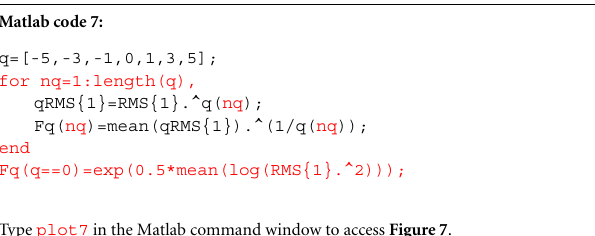
FIGURE 6 |The range of Hurst exponents defines a continuum of fractal structures between white noise ( H = 0.5) and Brown noise ( H = 1.5). The pink noise H = 1 separates between the noises H < 1 that have more apparent fast evolving fluctuations and random walks H > 1 that have more